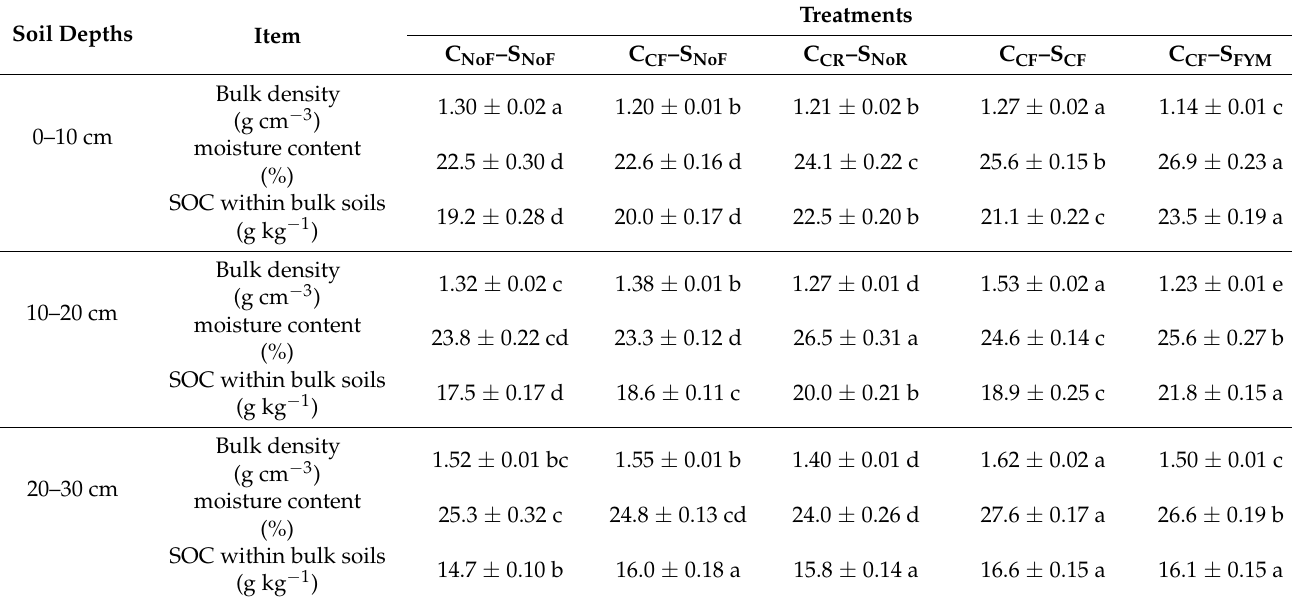
Table 3. Bulk density, moisture, and SOC contents within bulk soils.